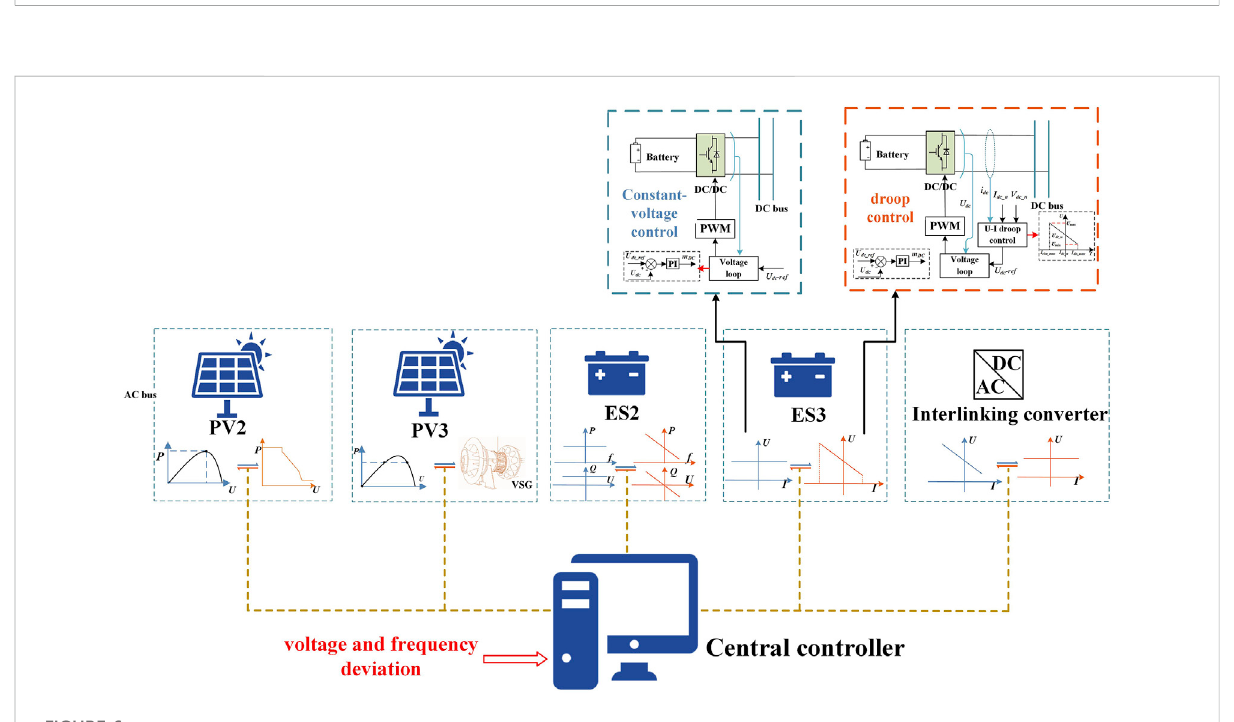
FIGURE 5 The control diagram of ES2.